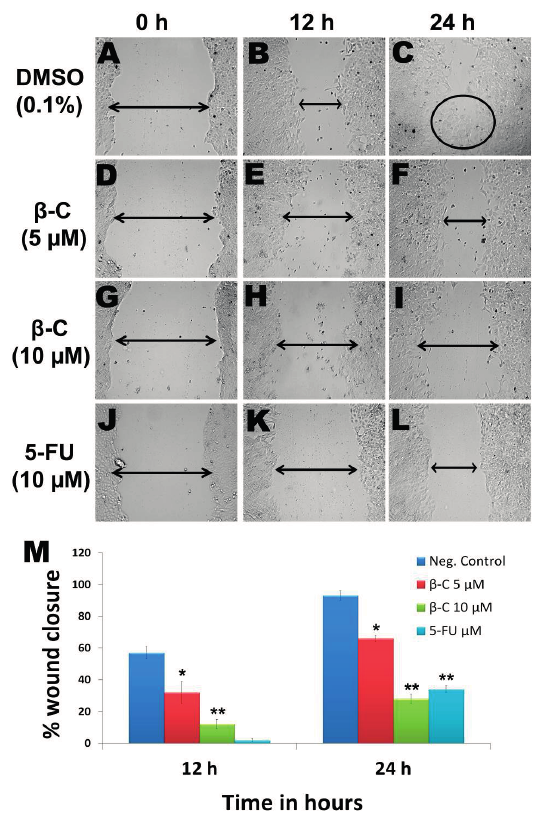
Figure 7. Due to the successful migration of HCT 116 cells in the untreated group (negative control), the wound is almost closed after 24 h ( A – C ), whereas in the β -caryophyllene-treated monolayer, the wound remained open even after 24 h incubation. β -Caryophyllene (5 μ M) caused a significant inhibition of HCT 116 cell migration ( D – F ). Interestingly, even at a sub-cytotoxic concentration (10 μ M), the compound caused significant inhibition of migration ( G – I ). The results can be compared with those of the standard reference 5-FU ( J – L ). Graphical representation ( M ) of the time and dose and time-dependent inhibitory effect of β -caryophyllene on migration of HCT 116 (values are in mean ± SD, n = 6, * p < 0.1, ** p <